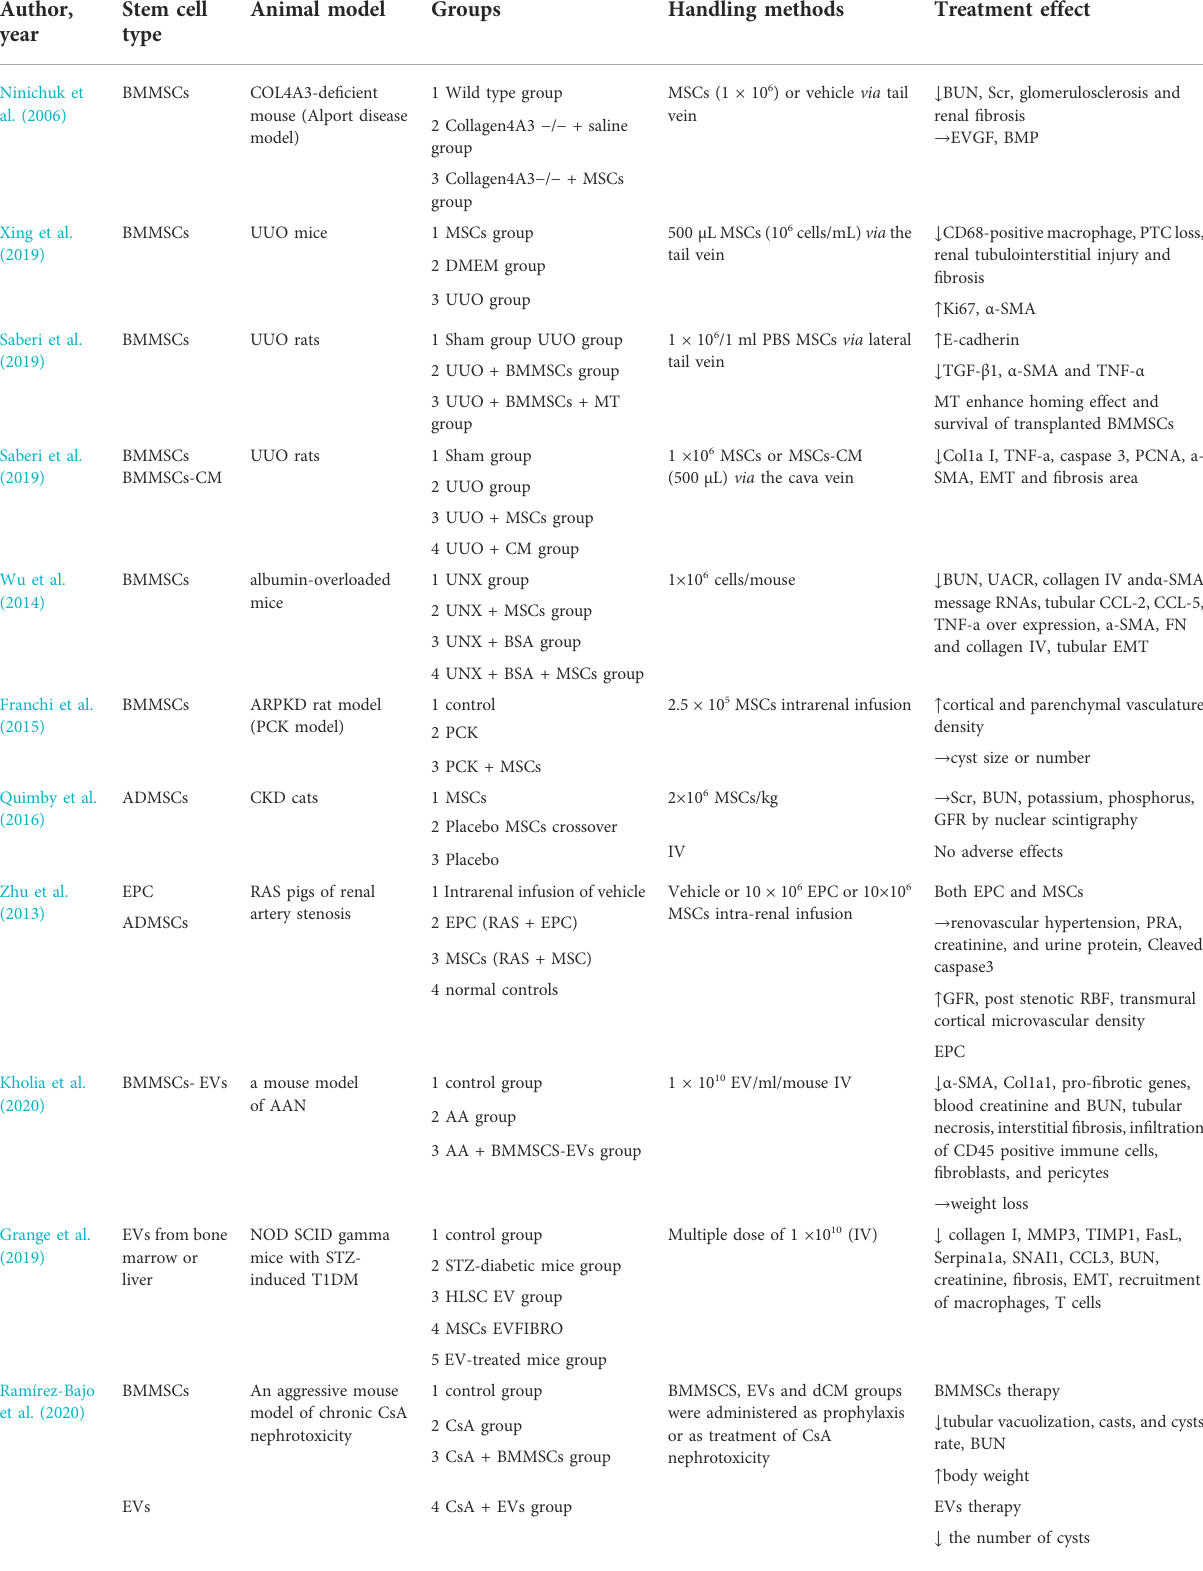
TABLE 1 ( Continued ) Summary of preclinical data of MSCs in